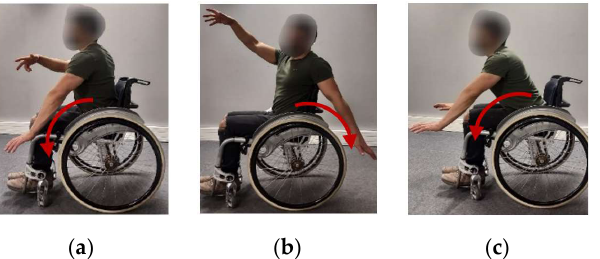
Figure 7. Examples of fake propulsion gestures: ( a ) left-forward, ( b ) left-backward, ( c ) forward.